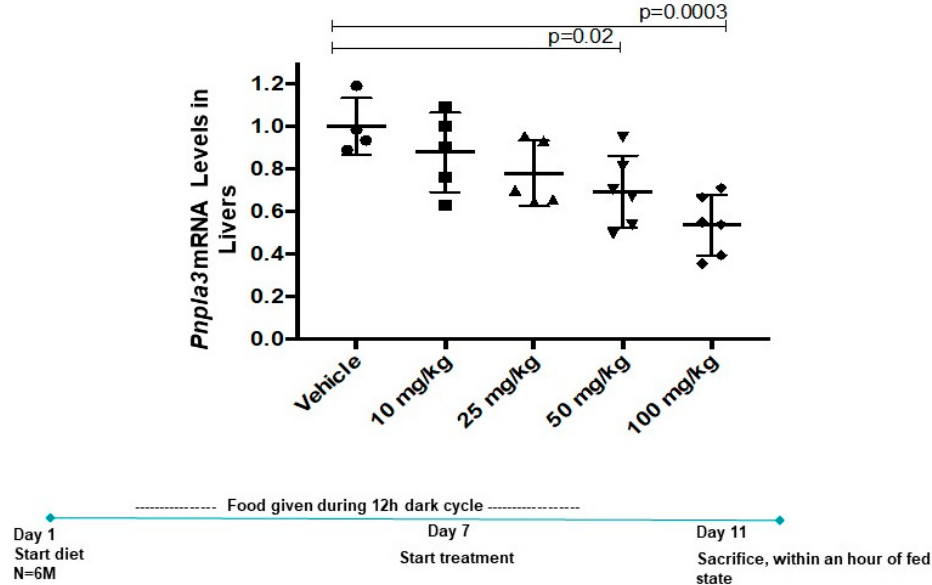
Figure 3. Momelotinib reduces Pnpla3 mRNA dose dependently in vivo. Hepatic Pnpla3 mRNA levels in WT mice administered five daily doses of momelotinib by oral gavage. Pnpla3 levels were first metabolically synchronized by providing mice access to a high sucrose diet only during the dark cycle, depicted in the scheme below the graph. Six animals were used per treatment group; mean and SD are shown. Significance was determined using one-way ANOVA.